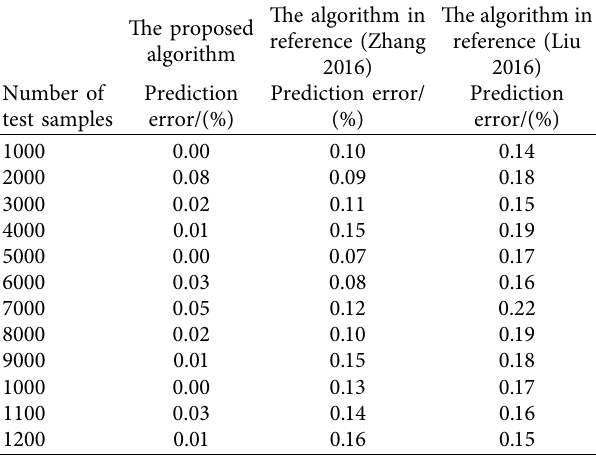
Figure 3: Correlation of financial data characteristics. Table 1: Prediction error changes of the three